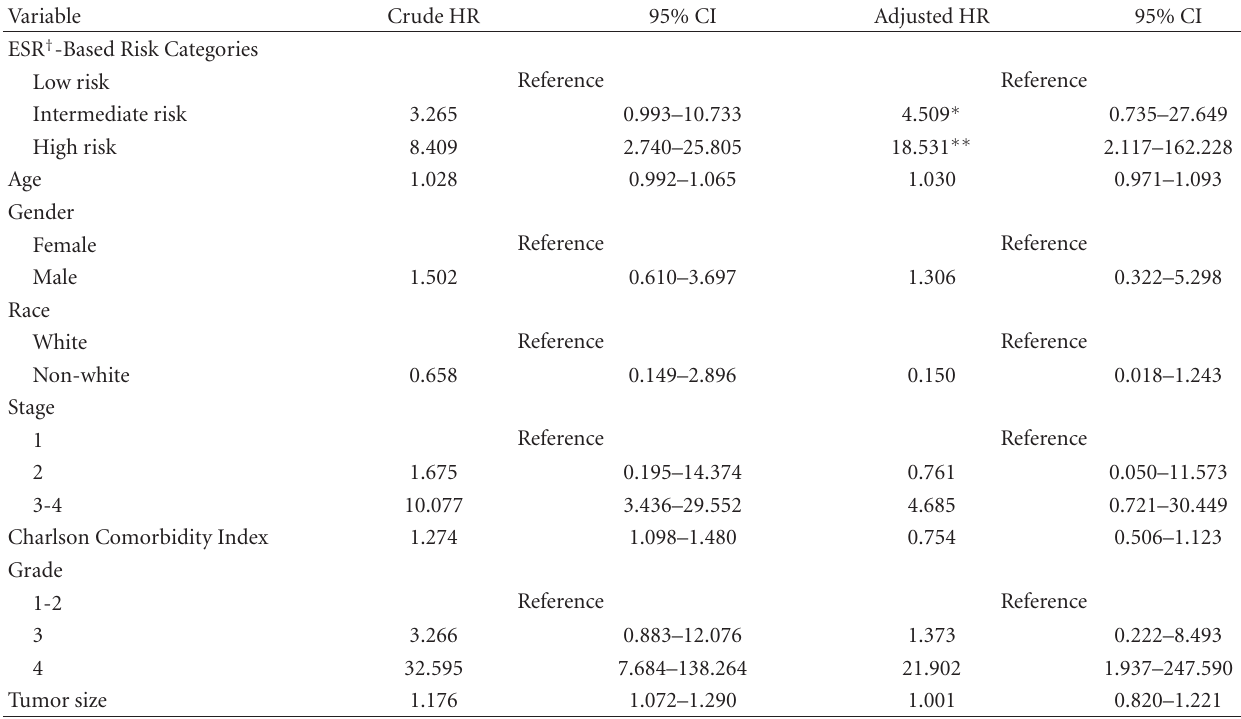
Table 2: Univariate and multivariate Cox regression analyses of predictors of overall survival